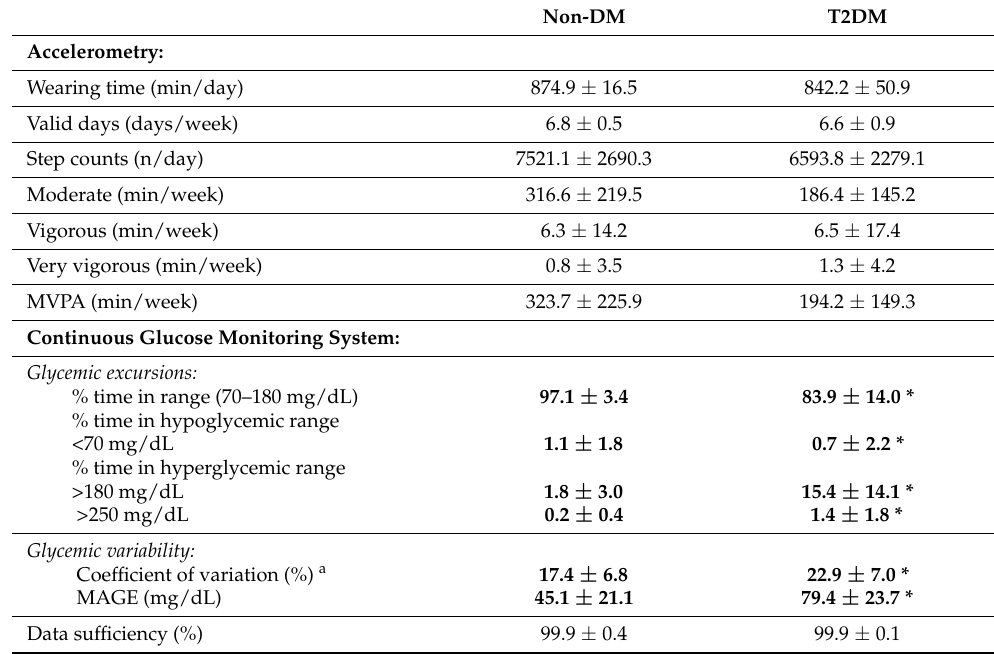
Table 3. Accelerometry and continuous glucose